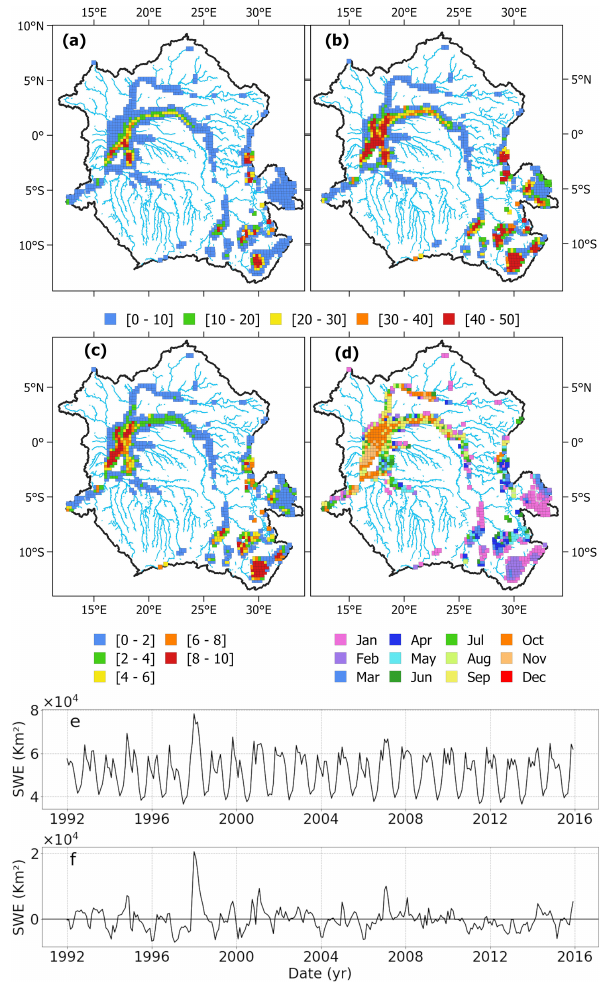
Figure 6. Characterization of SWE from GIEMS-2 over the CRB. (a) Mean SWE (1992–2015) for each pixel, expressed as a percent- age of the pixel coverage size of 773km 2 . (b) SWE variability (stan- dard deviation over 1992–2015; also in percent). (c) Annual max- imum SWE averaged over 1992–2015 (in percent). (d) Monthly mean SWE for 1992–2015 for the entire CRB. (e) Time series of SWE. (f) Corresponding deseasonalized anomalies obtained by subtracting the 24 years of mean monthly values from individual